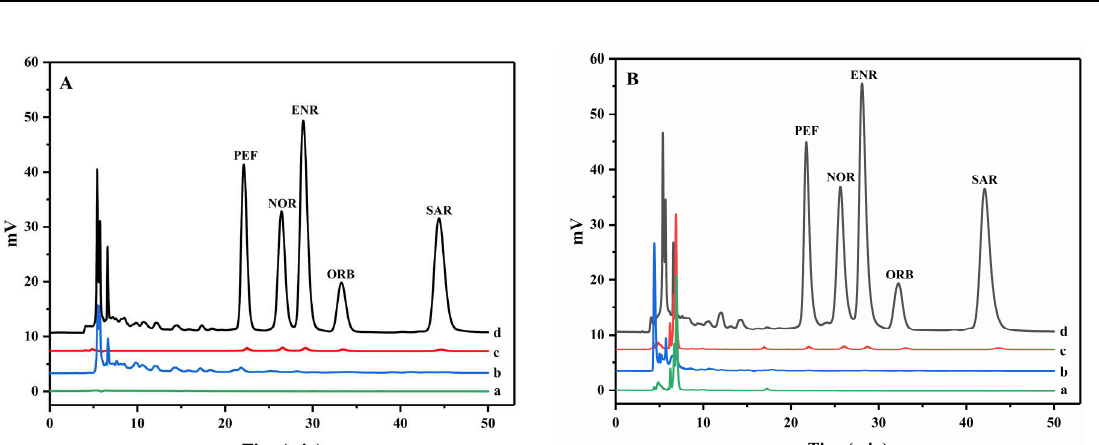
Figure 6. ( A ): HPLC-UV chromatograms of (a) honey sample; (b) honey sample after dSPE; (c) honey sample spiked with 100 ng·mL –1 before dSPE; and (d) honey sample spiked 100 ng·mL –1 after dSPE. ( B ): HPLC-UV chromatograms of (a) pork sample; (b) pork sample after dSPE; (c) pork sample spiked with 100 ng·mL –1 before dSPE; and (d) pork sample spiked 100 ng·mL –1 after dSPE.